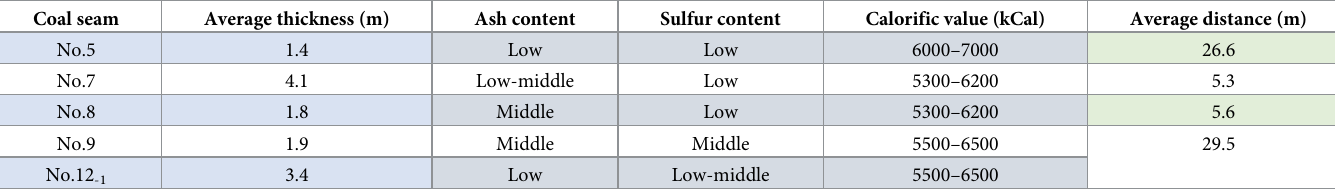
Table 1. Characterization of occurrence and quality of coal